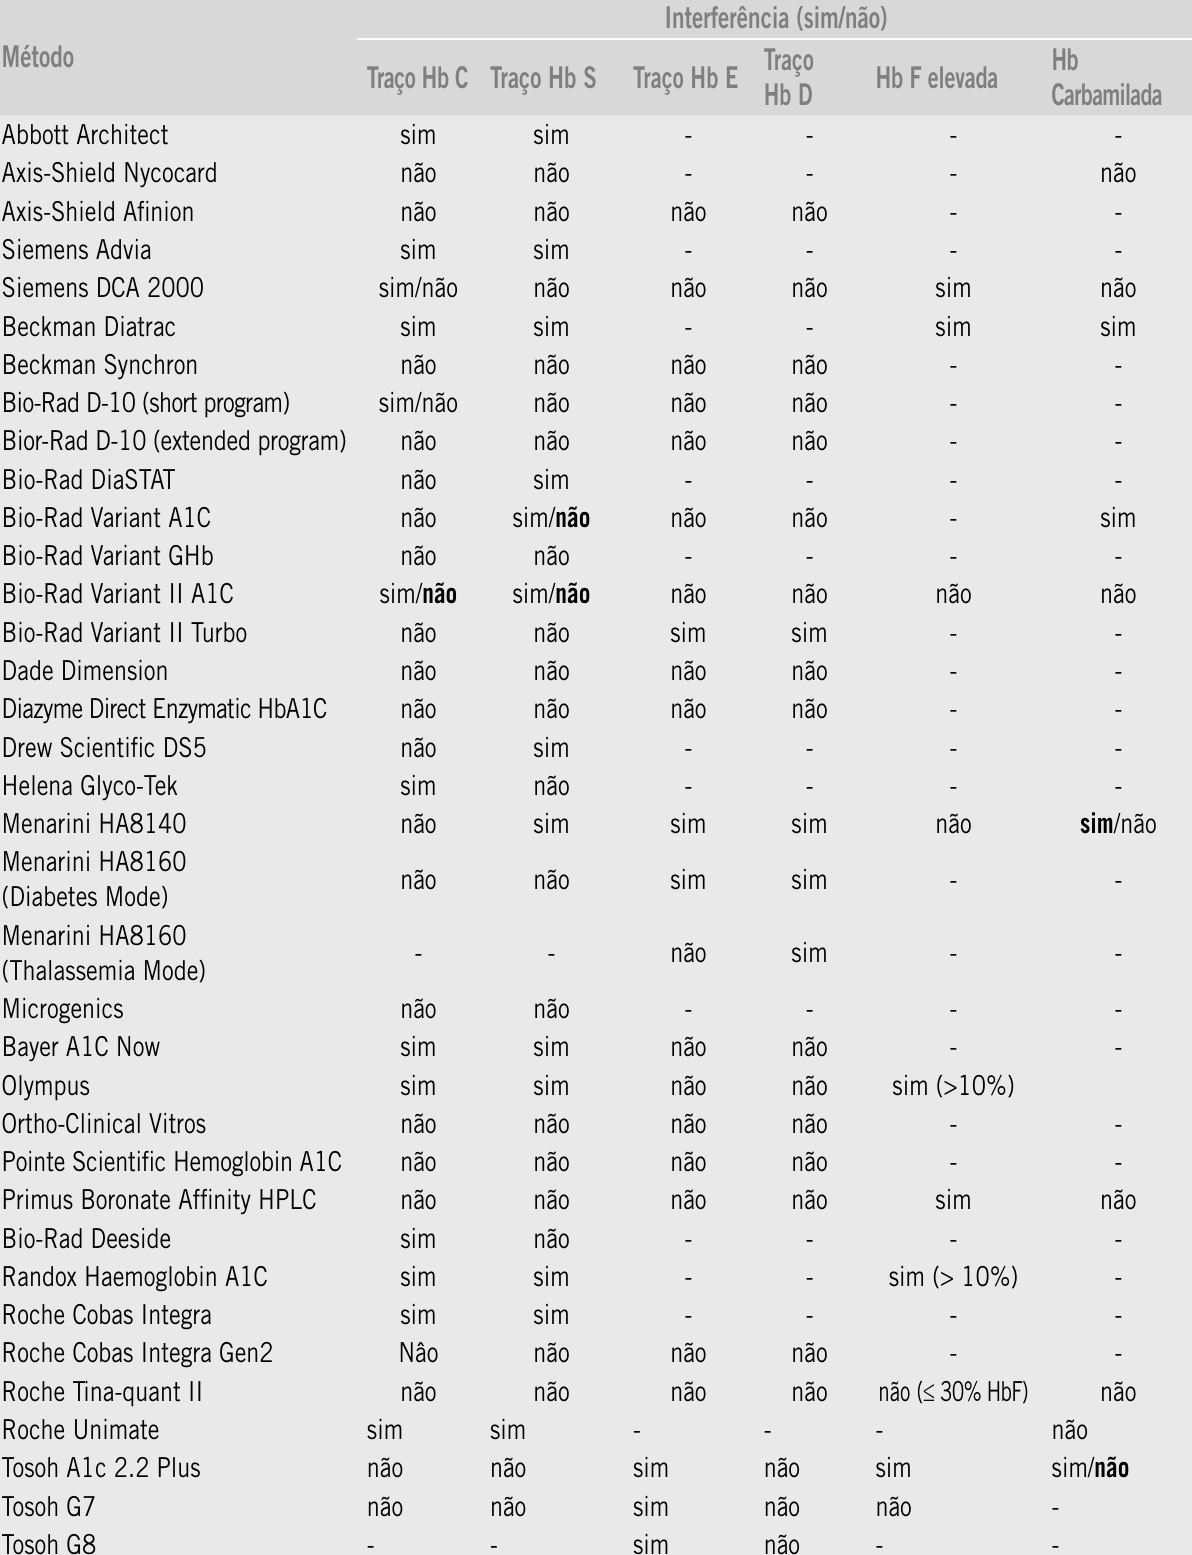
Interferência das hemoglobinas variantes e da hemoglobina carbamilada na dosagem da hemoglobina glicada, segundo NGSP, nas diferentes metodologias (atualizada em abril de